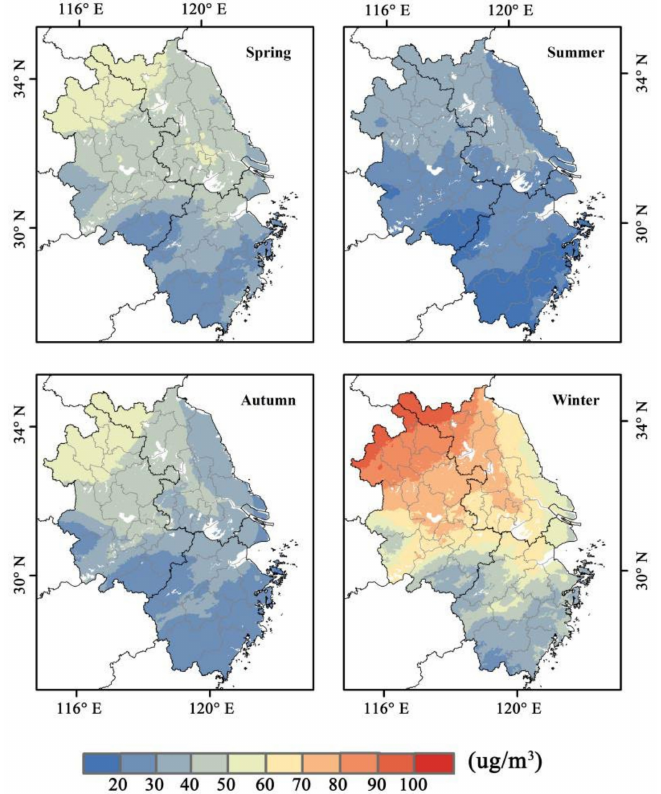
Figure A2. Spatial distribution of PM 2.5 concentrations in spring, summer, autumn. and